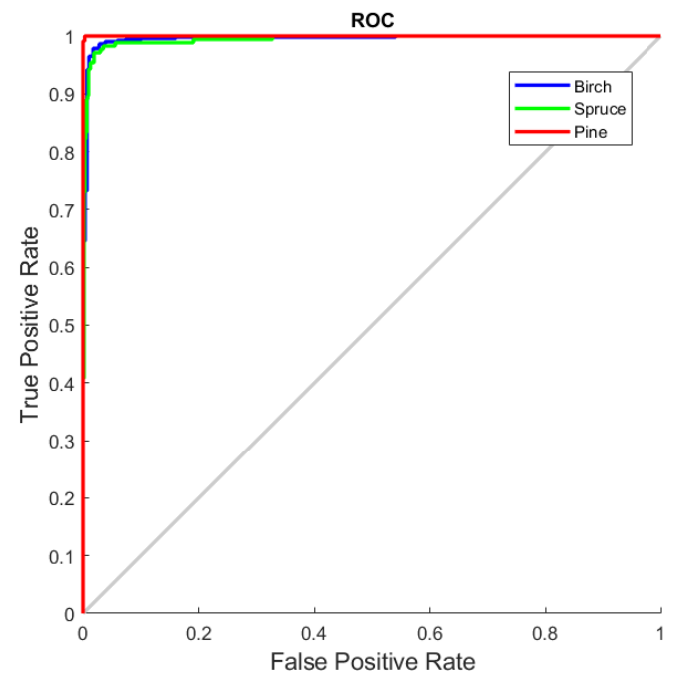
Figure 9. Receiver operative characteristic (ROC) curve of the 3D-CNN model for all layers. Table 3. Summary of the overall, producer’s, and user’s accuracies.